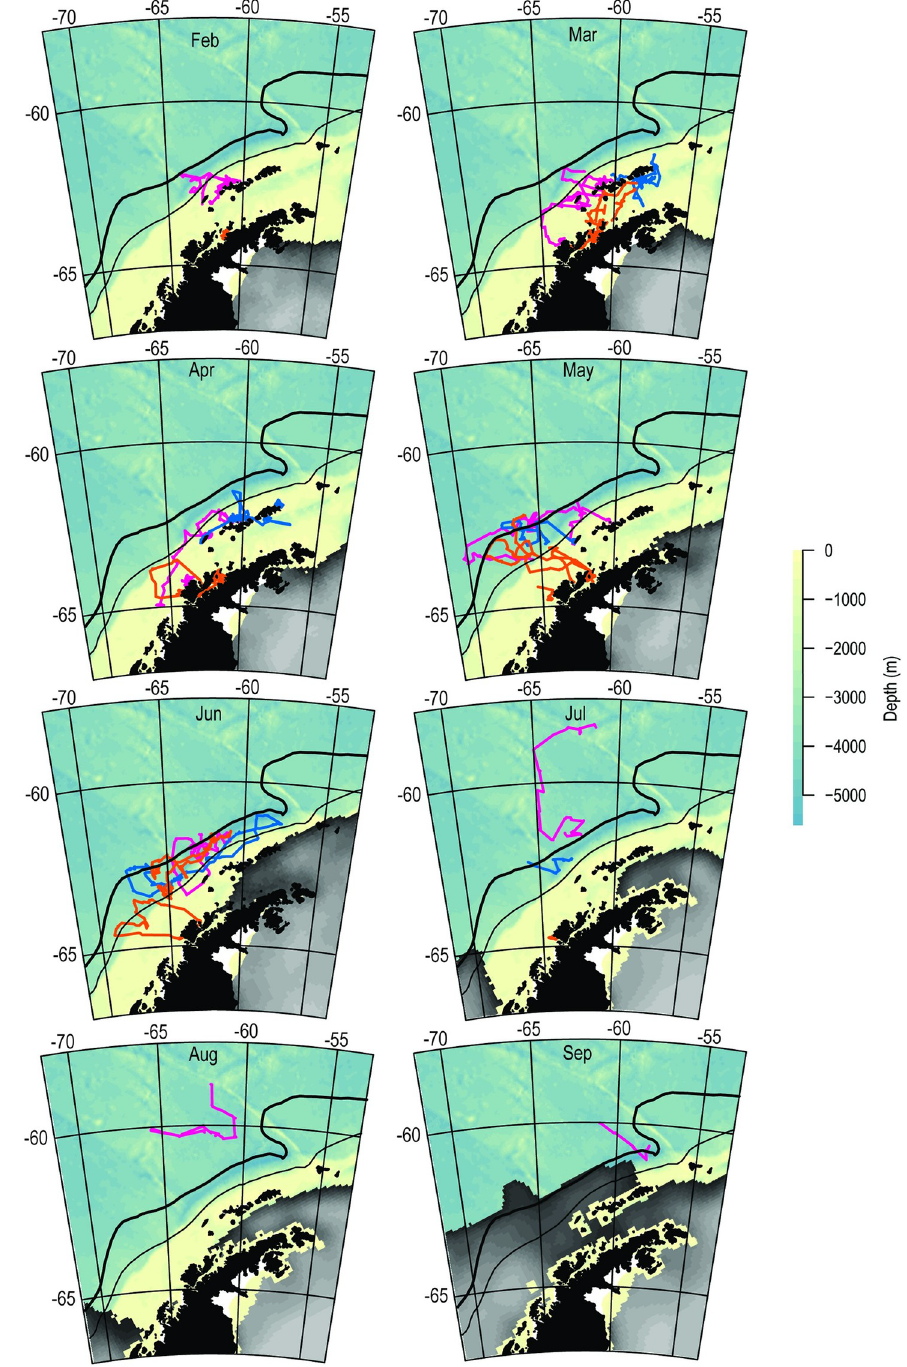
Fig 3. Monthly maps of penguins positions for ‘local’ individuals. Monthly at-sea locations for all ‘local’ chinstrap penguins originating from, and remaining within 500km of, Admiralty Bay (blue), Cape Shirreff (magenta), and Cierva Cove (orange). Tracks are overlaid on bathymetry and mean monthly sea-ice concentrations, February— October, 2017. The Polar Front (thick solid line), southern Antarctic circumpolar current front (thin solid line) and southern boundary of the Antarctic circumpolar current (thin dashed line) are plotted for reference. White areas indicate no data.